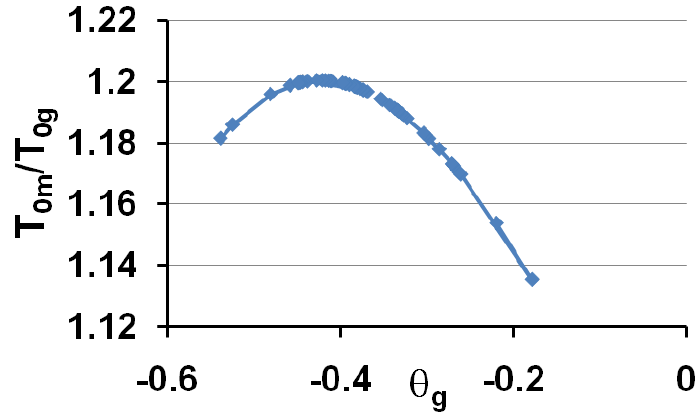
Figure 8. The ratios of the free-volume disappearance temperatures T versus  = (T − T )/T g g m m